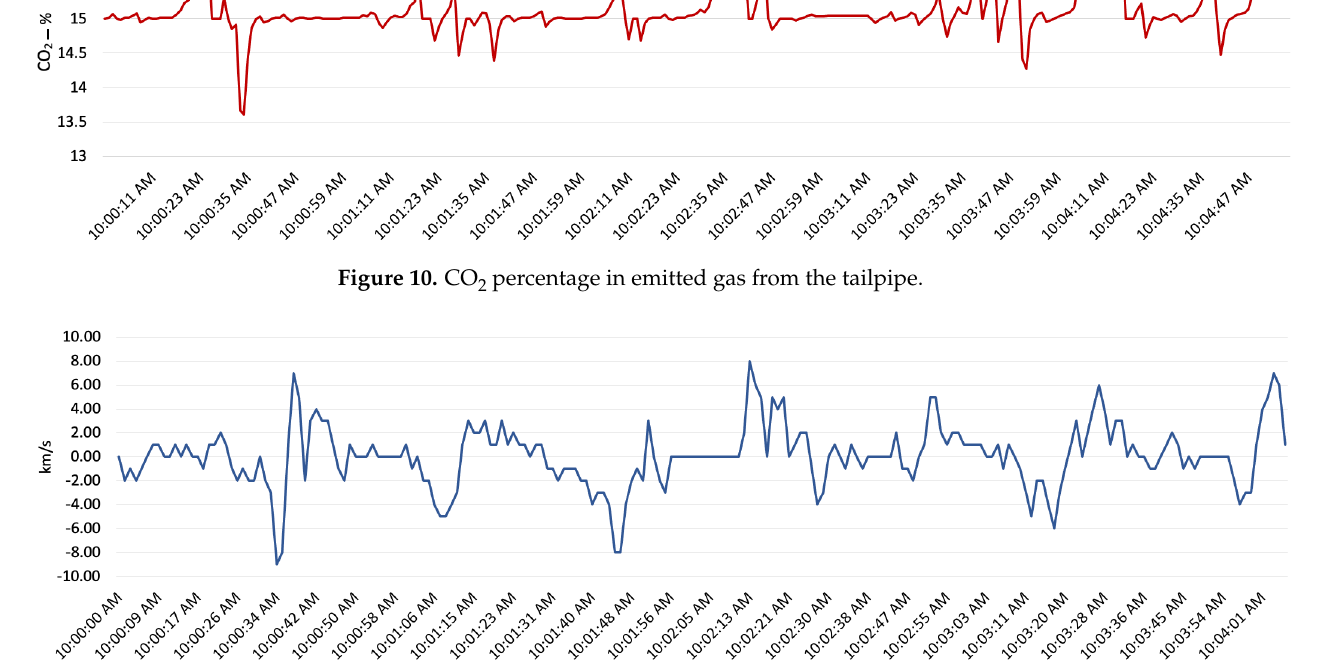
Figure 11. Acceleration and deceleration of the